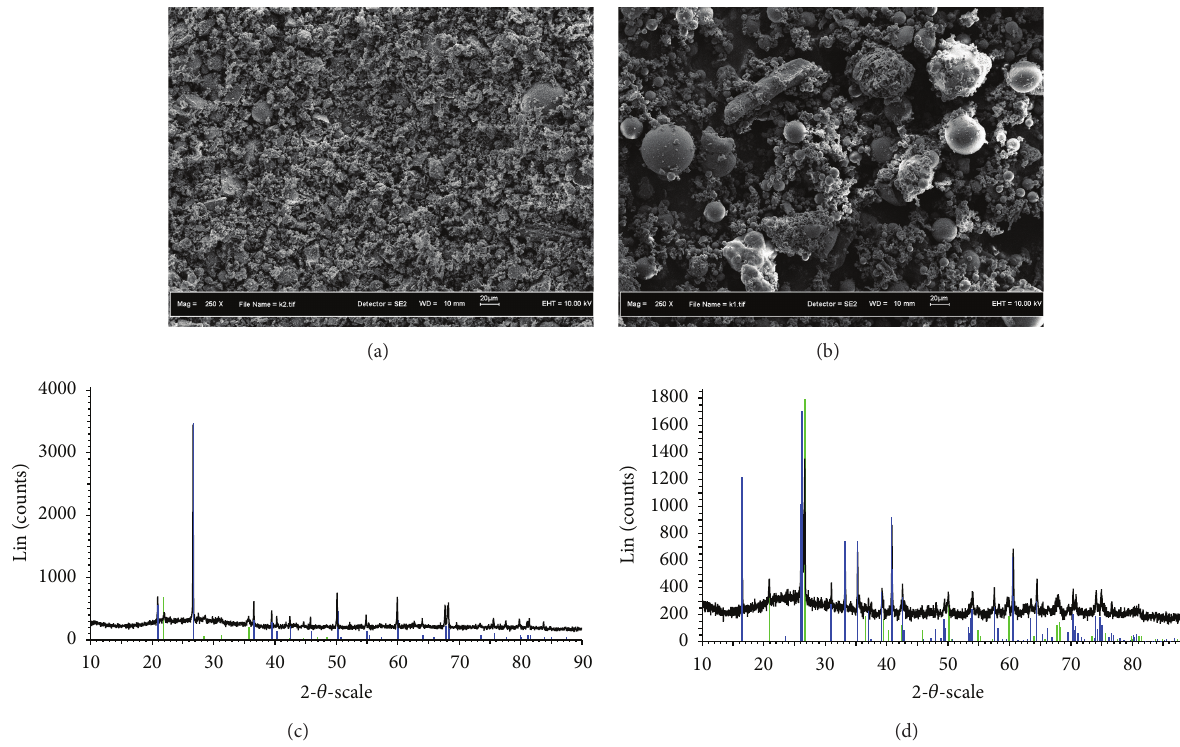
Figure 1: (a) Scanning electron micrograph of POFA, (b) scanning electron micrograph of PFA, (c) X-ray diffraction pattern POFA, and (d) X-ray diffraction pattern PFA.